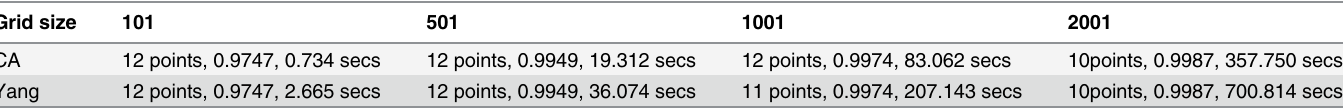
Table 4. Number of support points in the generated designs from the Cocktail and Optimal Weights Exchange algorithms using different grid sizes, their relative D -efficiencies and CPU times for the Becker ’ s Model